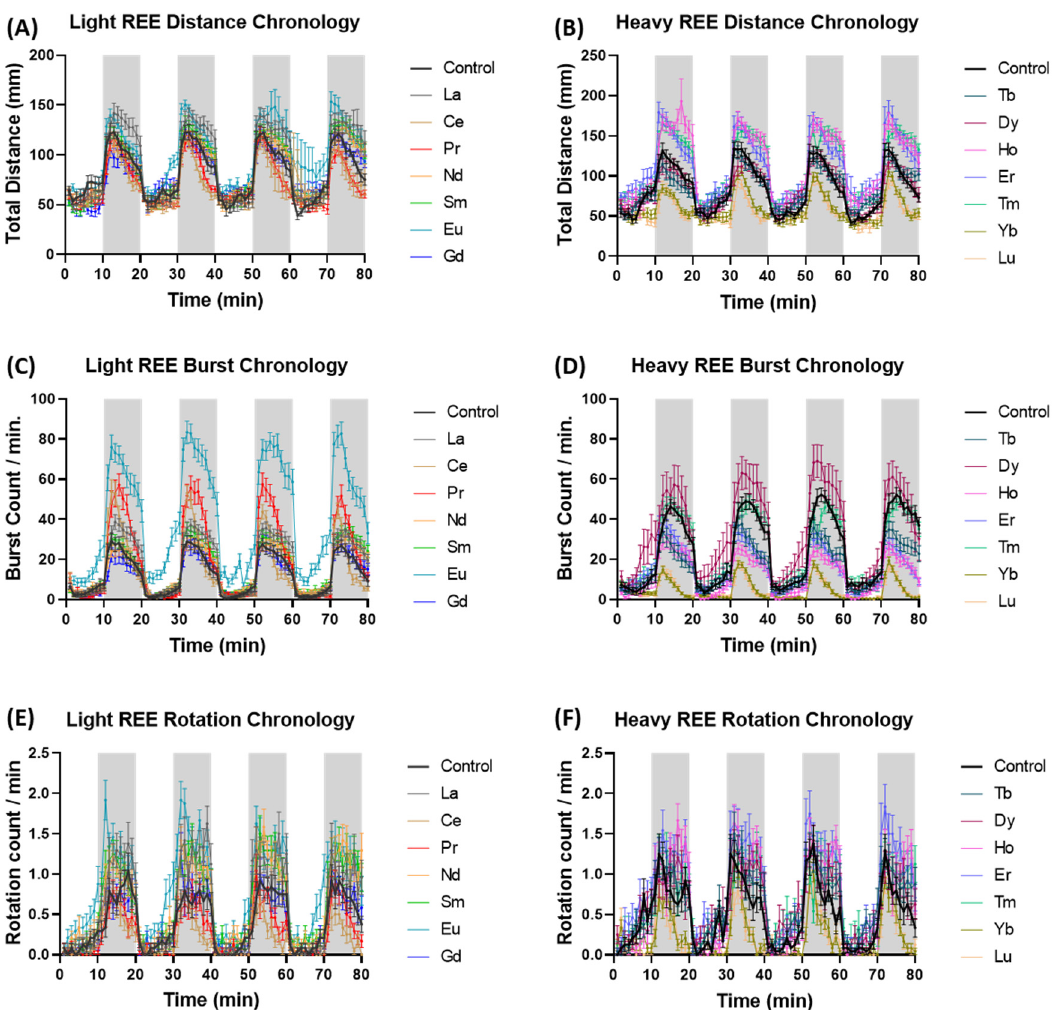
Figure 2. Swimming activity of zebrafish after exposure to different Lanthanides. The mean ± SEM of ( A , B ) distance traveled, ( C , D ) burst movement, and ( E , F ) rotation counts per minute by zebrafish larvae after 24 h exposure of 1 ppm LREE and HREE during both light and dark cycles. A two-way ANOVA test with Geisser-Greenhouse’s correction continued with Dunnett’s multiple comparisons test was carried out to compare all treatments with the control (presented in Table S2).